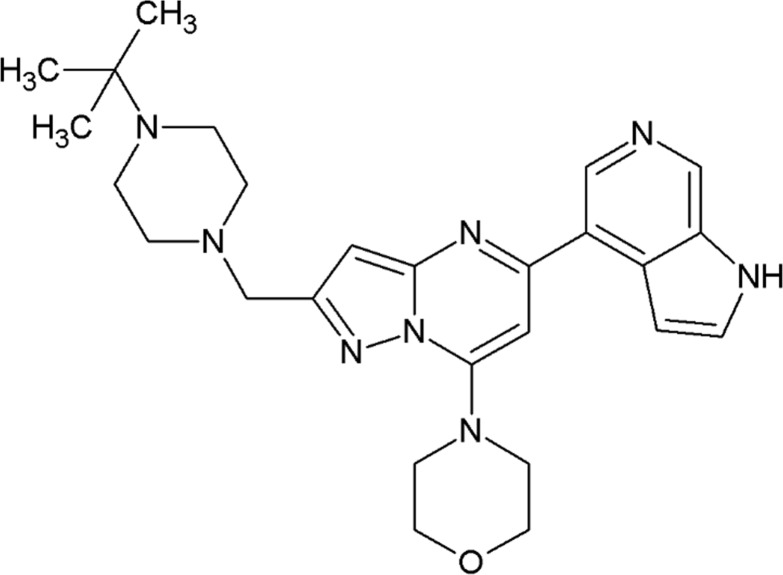
CPL302-253 chemical structure.